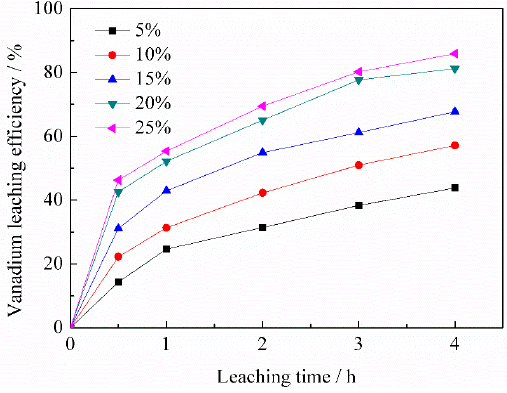
Figure 8. Effect of sulfuric acid concentration on vanadium leaching efficiency.